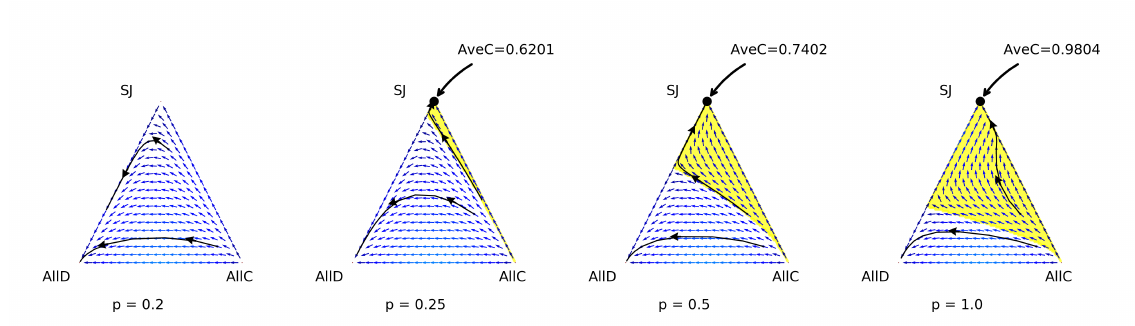
Figure 1. Replicator dynamics of hybrid assessments. Each triangle represents a simplex of the state space, where x , y , and z are non-negative real numbers denoting the frequencies of unconditional cooperators (AllC), unconditional defectors (AllD), and the stern judgers (SJ), respectively. The arrows in the triangles show the direction of replicator dynamics at each point. Trajectories following the dynamics are also drawn. If the top vertex ( x , y , z ) = ( 0,0,1 ) is asymptotically stable, the average rate of cooperation (AveC) at that point is calculated and the basin of attraction is shown in yellow. The four triangles represent the results for different values of p . The parameter values are b = 3, c = 1, e (cid:48) = 1%, and e =